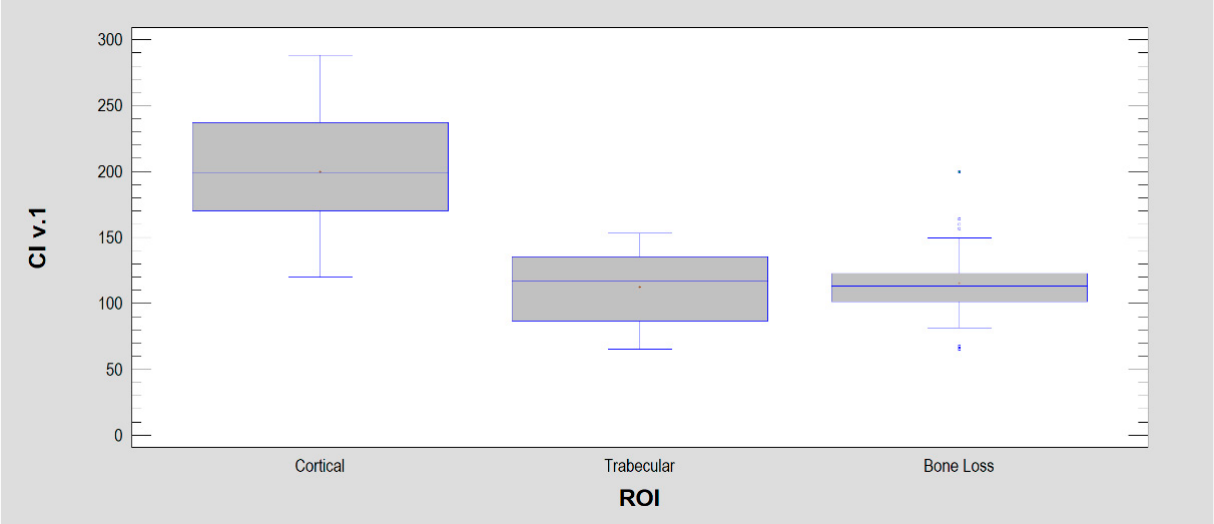
Figure 5. Corticalization index ver. 1 (CI v. 1) is based on two components included in BI and mean optical density. The components are arranged inversely to the BI to emphasize the corticalization sites rather than trabeculation, and the mean optical density enhances this effect because it is located in the numerator and is highest in the cortical bone.